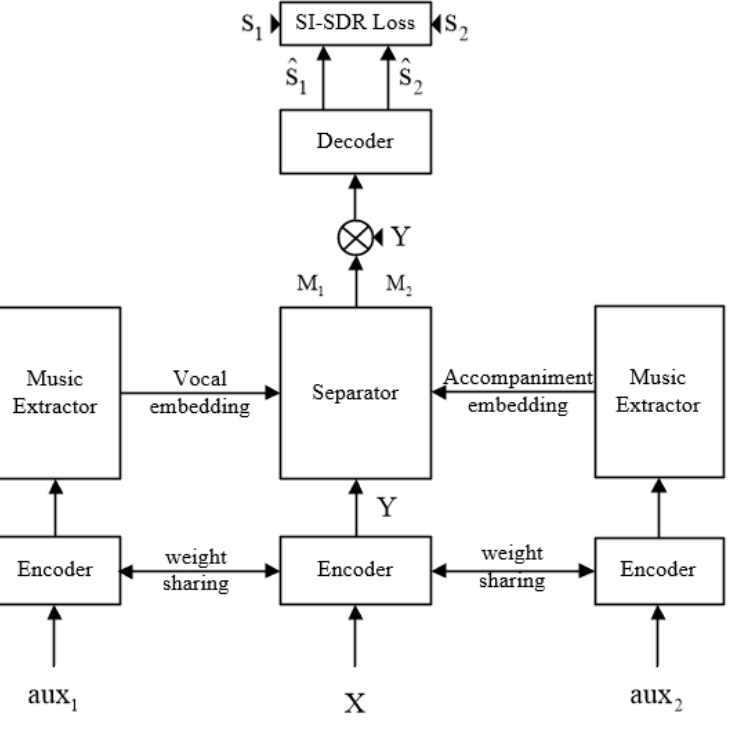
Figure 3. A schematic diagram of VAT-SNet.